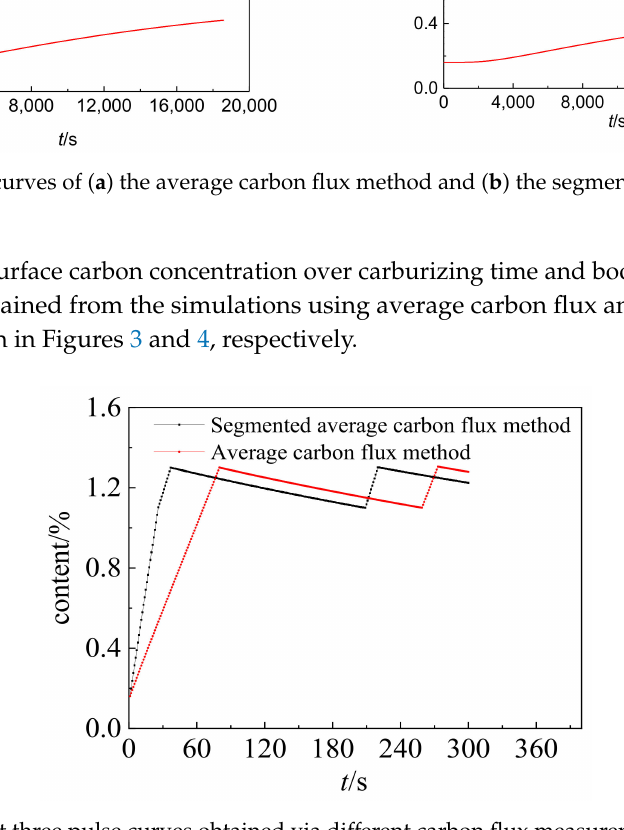
Figure 3. First three pulse curves obtained via di ff erent carbon flux measurement